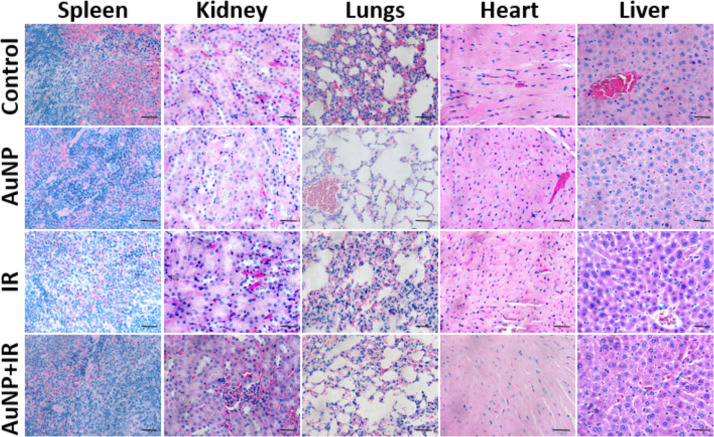
Evaluation of treatment toxicity.H&E staining indicated no detectable toxicity in surrounding visceral organs such as spleen, kidney, lungs, heart, and liver due to either AuNP and/or radiation treatment. Scale bar: 50 μm.